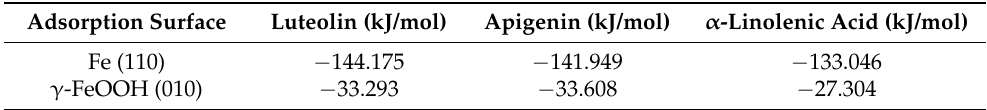
Table 6. Adsorption energy of corrosion inhibitor molecules.